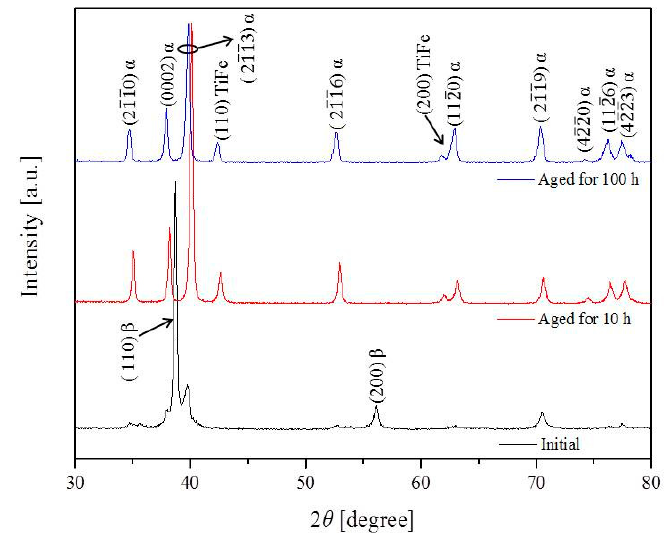
Figure 3. XRD patterns of initial Ti-5Al-3.5Fe alloy and alloy after aging at 500 ° C for 10 or 100 h.